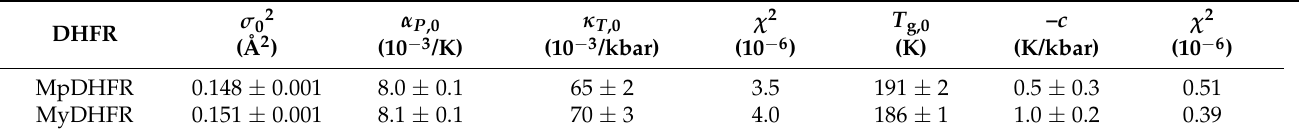
Table 2. Parameters calculated from QHA. Goodness-of-fit given by reduced χ 2